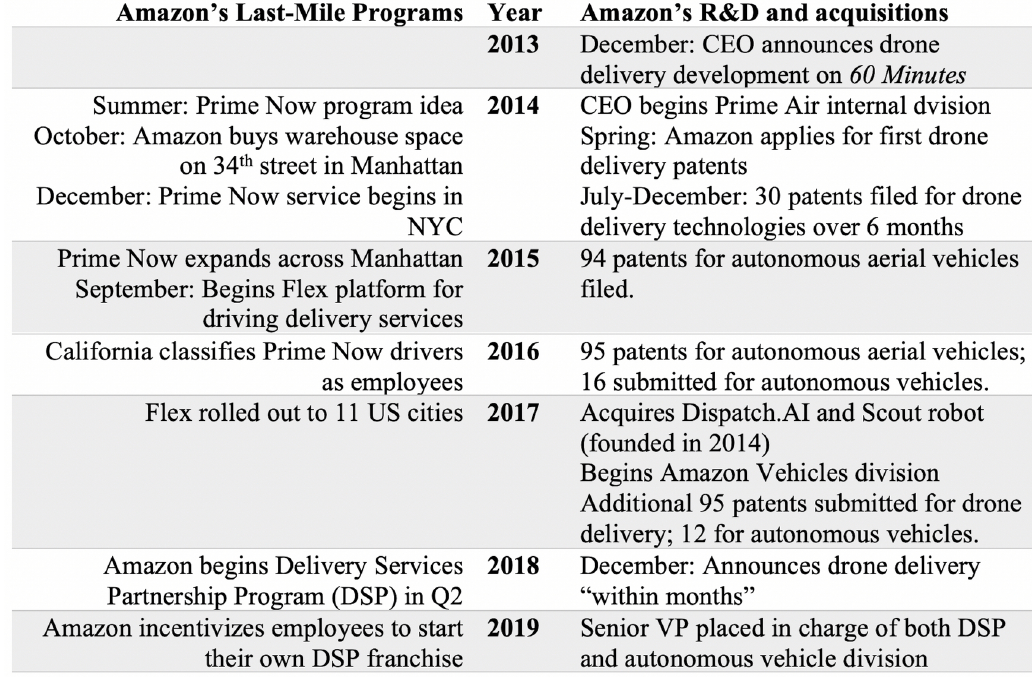
Figure 1: Parallel timelines for development of automated services and Prime Now, Flex, and DSP. Sources: LexisNexus, US Patent Database, TechCrunch,